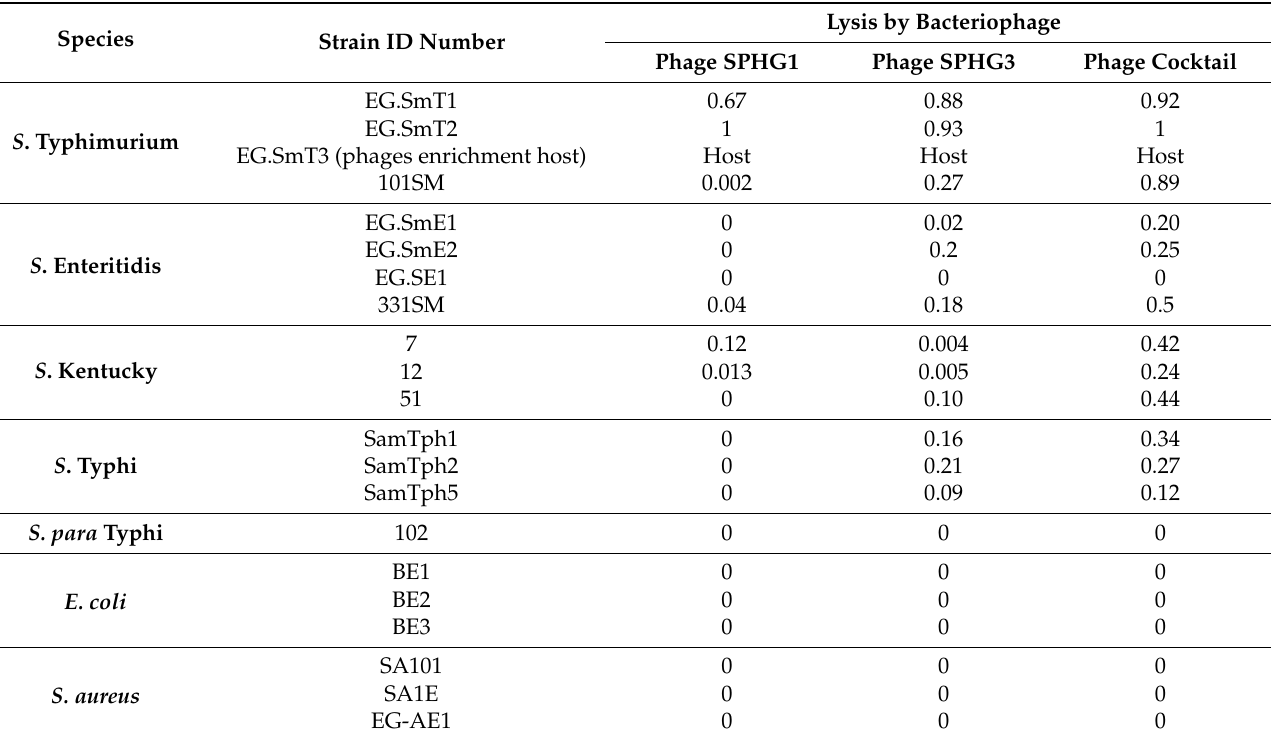
Table 1. The efficiency of plating (EOP) by phages SPHG1, SPHG3, and cocktail mix of these phages against different